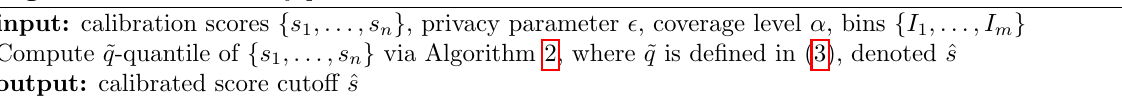
Algorithm 3 Differentially private calibration